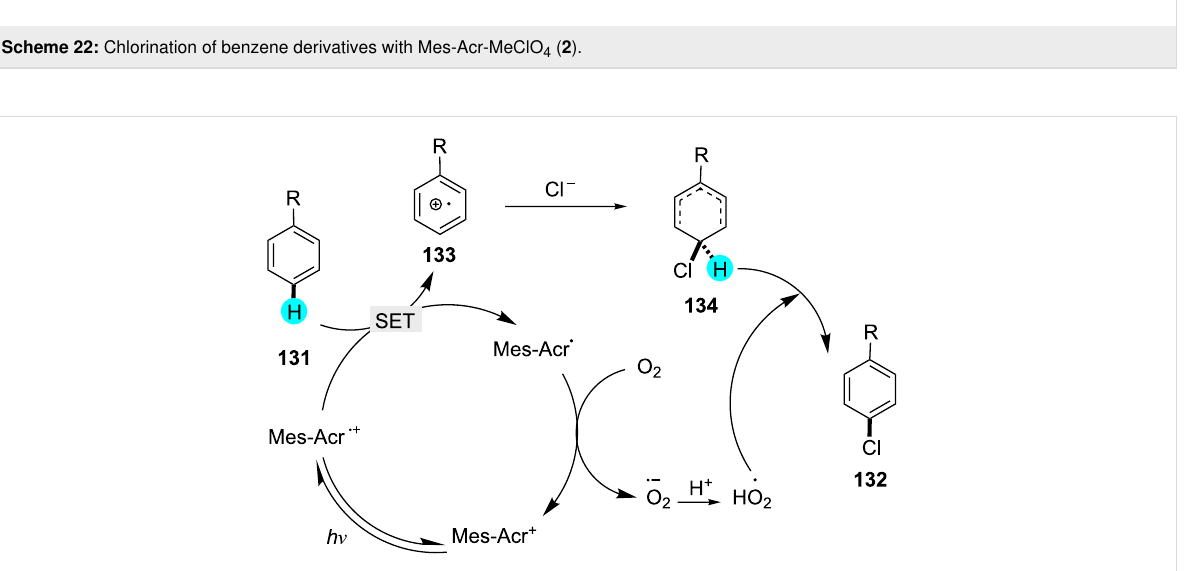
Figure 22: Mechanism for the synthesis of 131 from 132